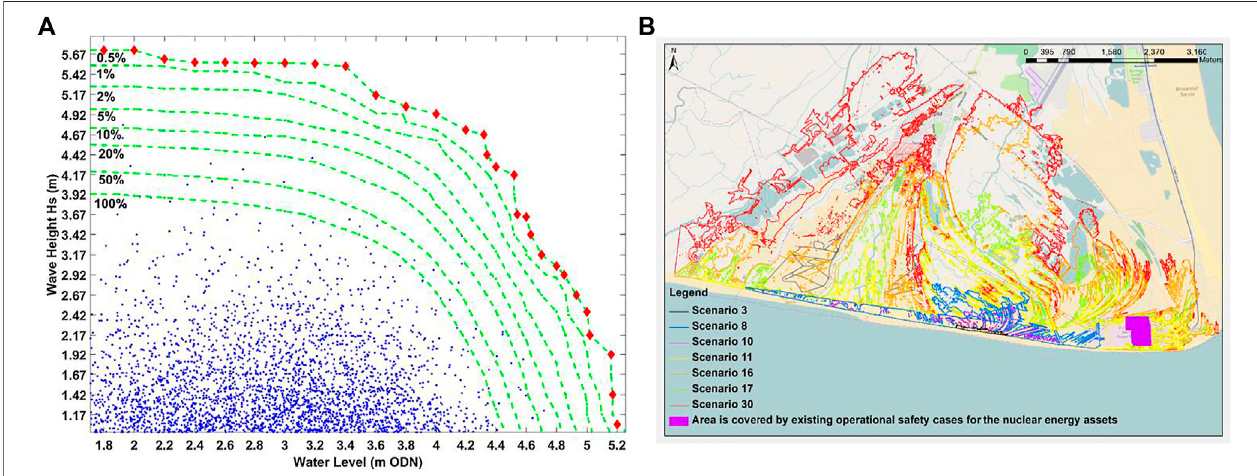
FIGURE 2 | (A) : joint Hs and WL probability curves of the observed conditions at Dungeness (the blue dots represent wave height and water observations at Dungeness; the green lines are the probability curves (the annual probability of occurrence shown ranges from 100% down to 0.5%); the red diamonds show the 30 selected combinations of wave height and water level that are modelled in the fi gure on the right). (B) : maximum fl ood extent outlines for seven selected scenarios (Thomas et al., 2016).